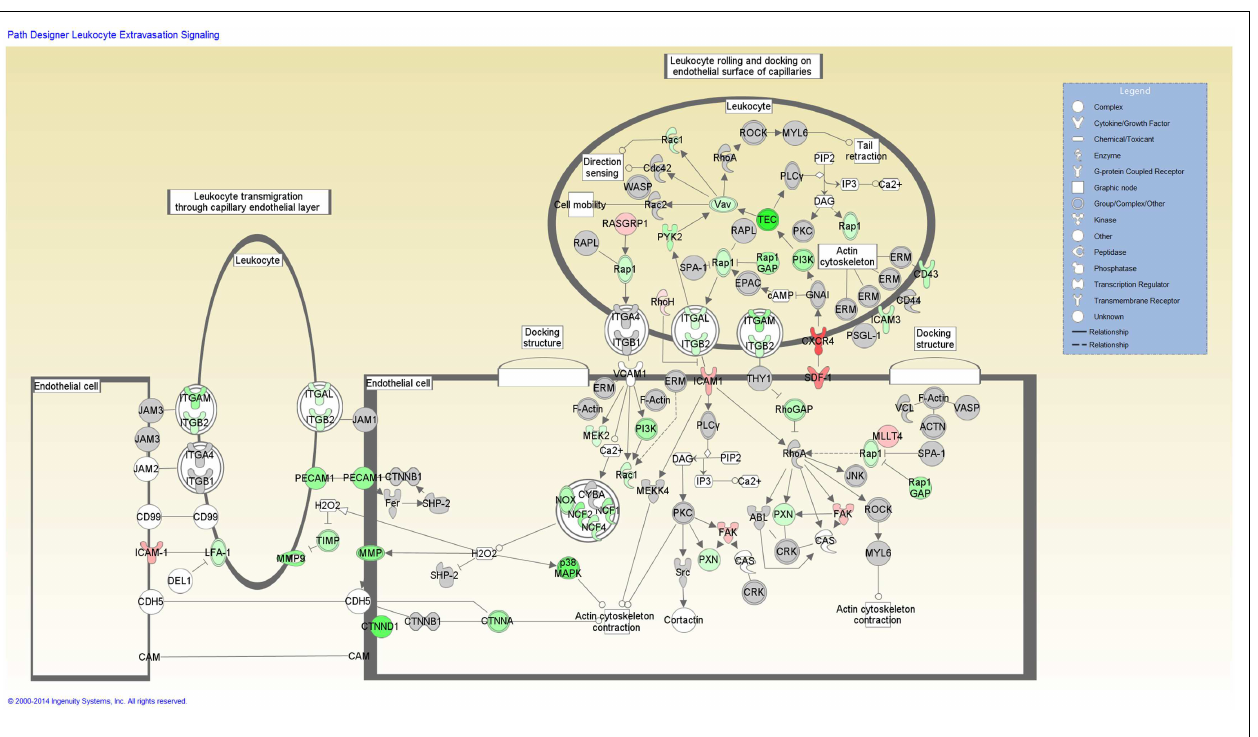
FIGURE 3 |The second-ranked enriched canonical pathway identified using IPA, the Leukocyte extravasation pathway . Red shading indicates increased expression in M. bovis -infected animals